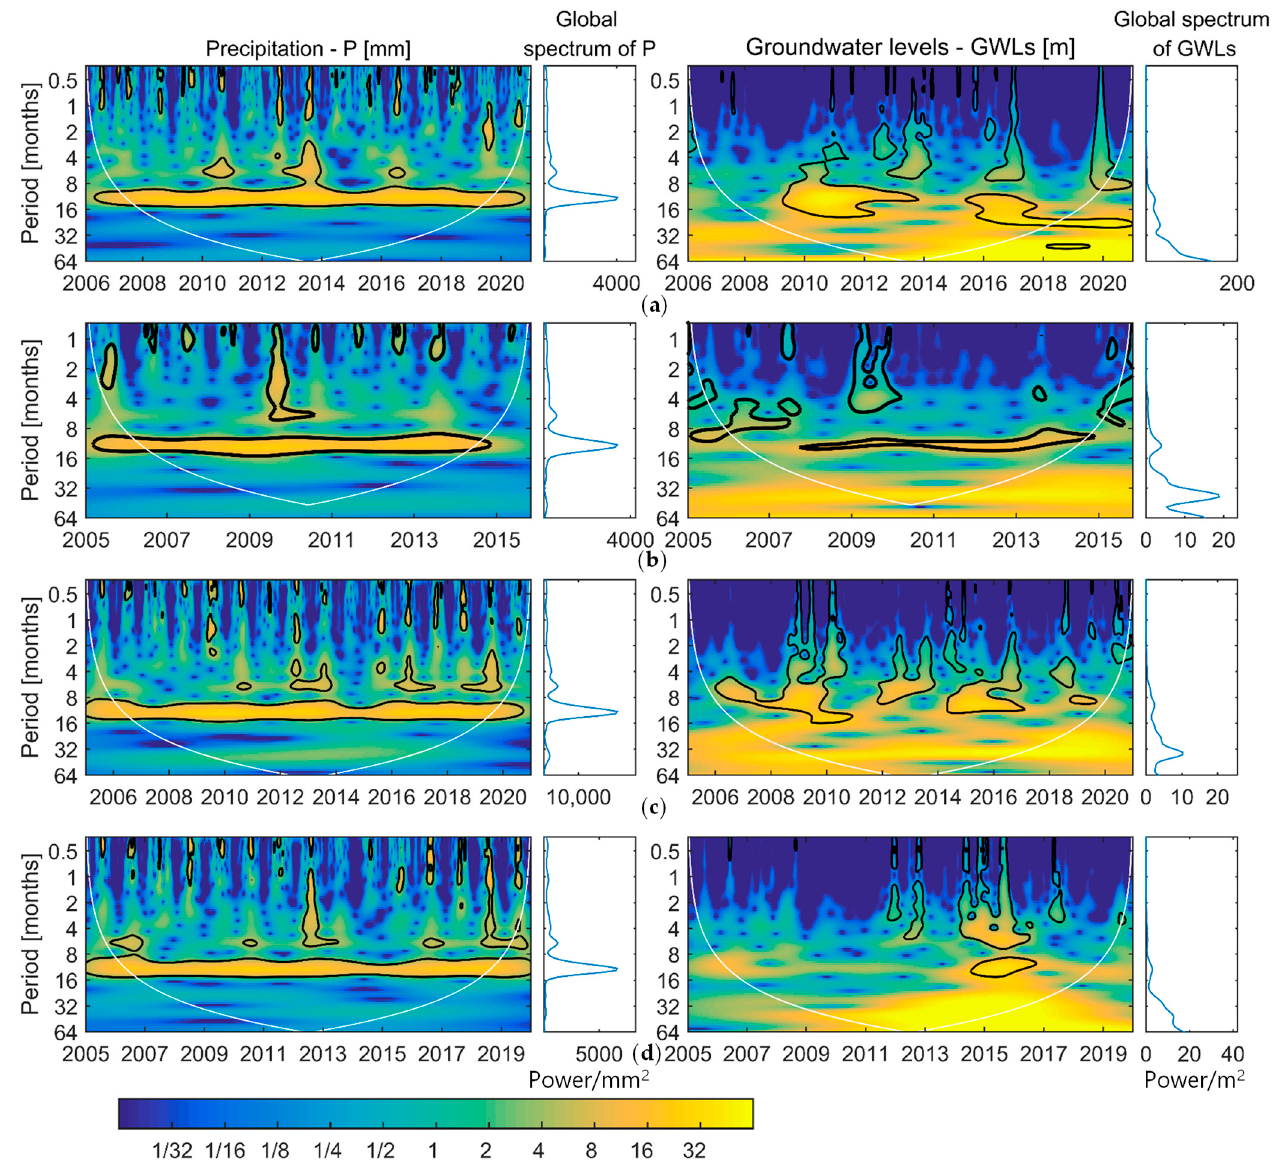
Figure 6. Continuous wavelet spectra for both precipitation and GWLs at ( a ) W1, ( b ) W2, ( c ) W3, and ( d ) W4, with the global wavelet spectrum right side of each subplot. Zones surrounded by black lines have signi fi cant wavelet power at the 95% con fi dence level. White lines denote the cone of in fl uence.